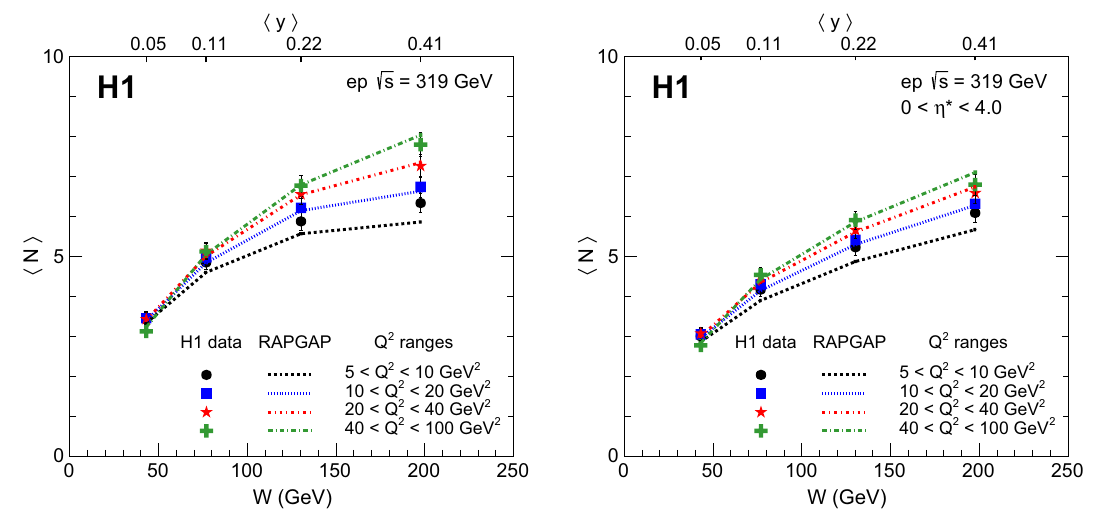
√ s = are given in Table 1. The corresponding (cid:8) y (cid:9) is indicated by the top axis for each measured W . Predictions from the RAPGAP model are shown by dashed lines. The total uncertainty is represented by the error